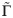
Extent of the MC-HD shock phase for L = 1, depending on Γ˜ (analytical results); black line: Γ˜=0, blue lines: Γ˜=0.01, green lines: Γ˜=0.1 and the purple line: Γ˜=0.5.The insets show the full phase diagram for these three values.